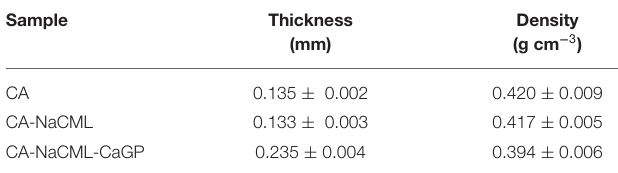
TABLE 2 | Thickness and density of the